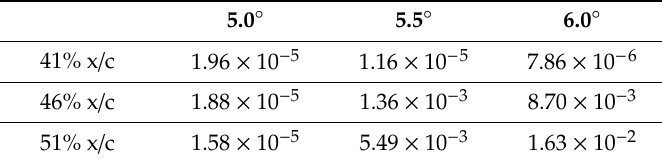
Table 1. PSD peak values under the “Blow_1.0_Ptot” condition.